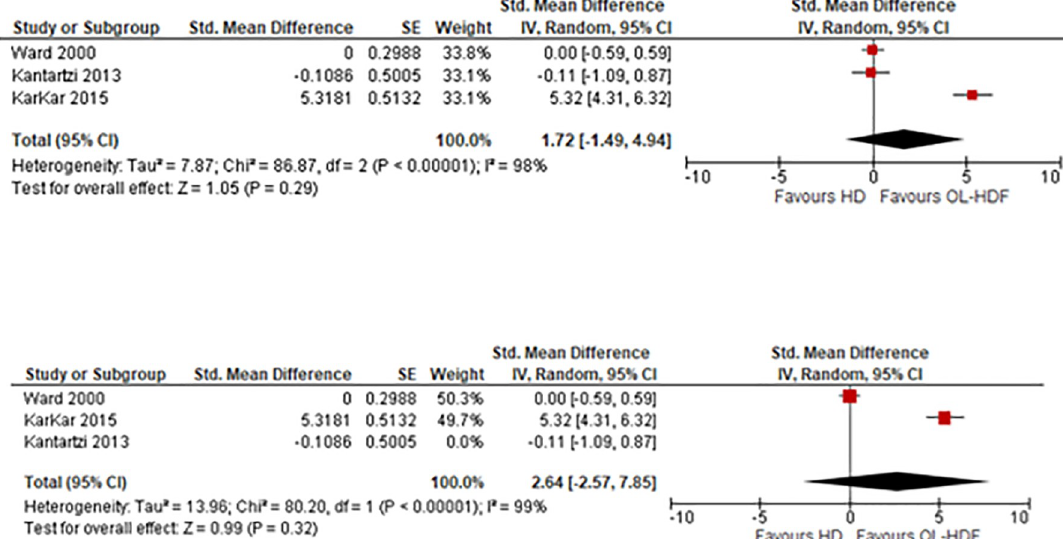
Fig 6. Fig 6–1. Meta-analysis of Fatigue, Fig 6–2. Sensitivity analysis of Fatigue.